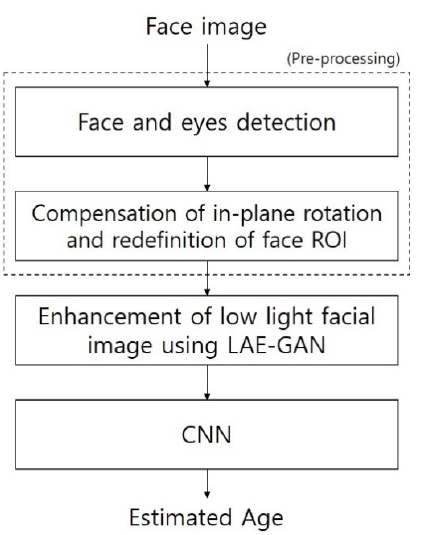
Figure 1. Overall procedure of the proposed method.